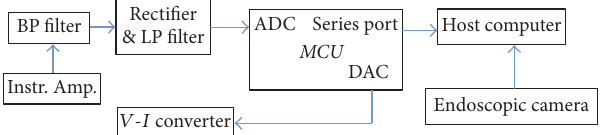
Figure 2: Schematic diagram of pacing instrument